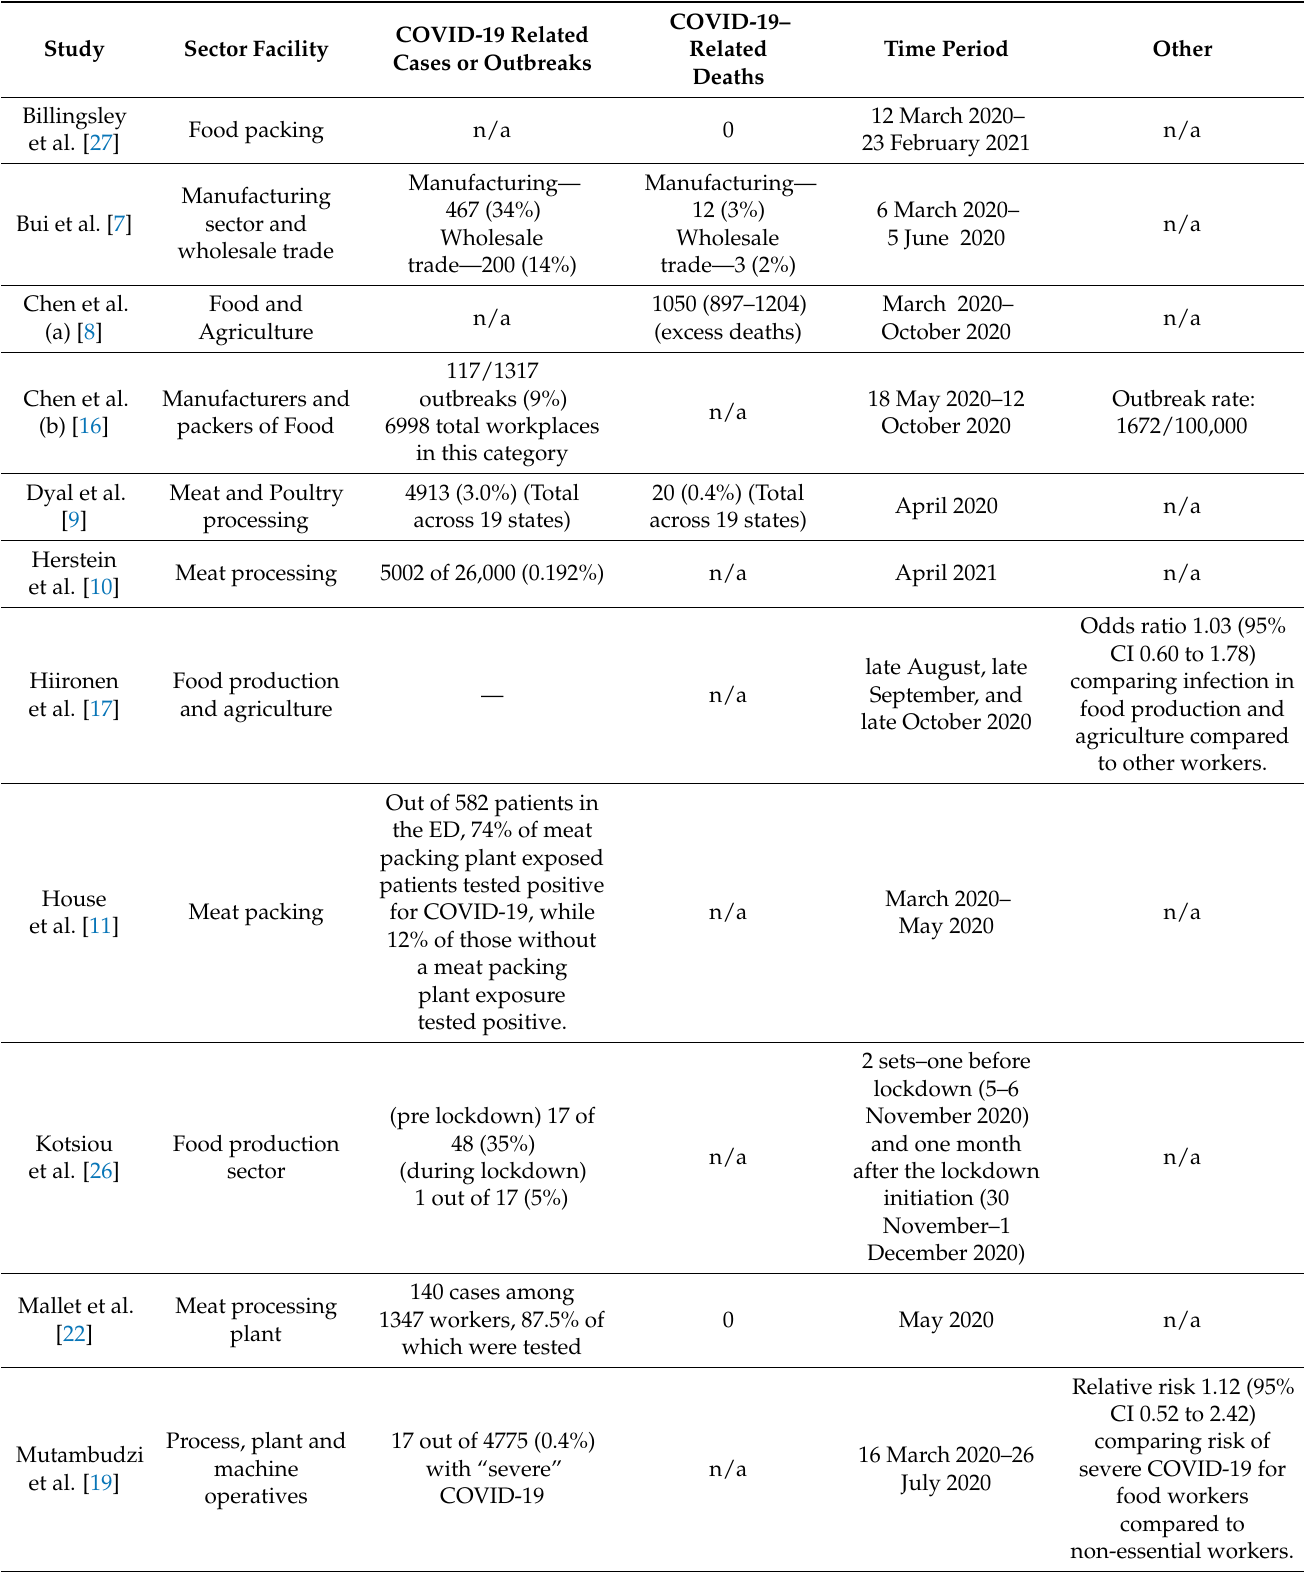
Table 2. Summary of study findings for COVID-19 related cases and infection and mortality